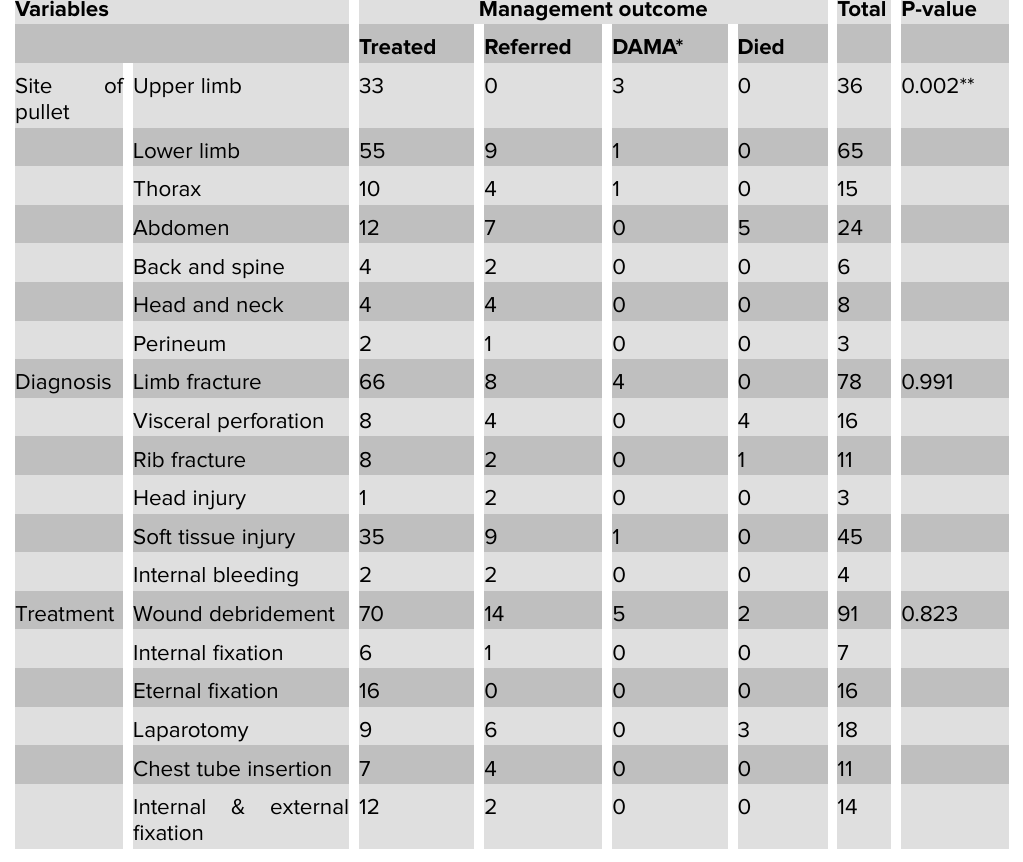
Table 2: Management outcome in relation to the site of pullet, diagnosis, and treatment. Variables Management outcome Total P-value Treated Referred DAMA* Died Site of Upper pullet